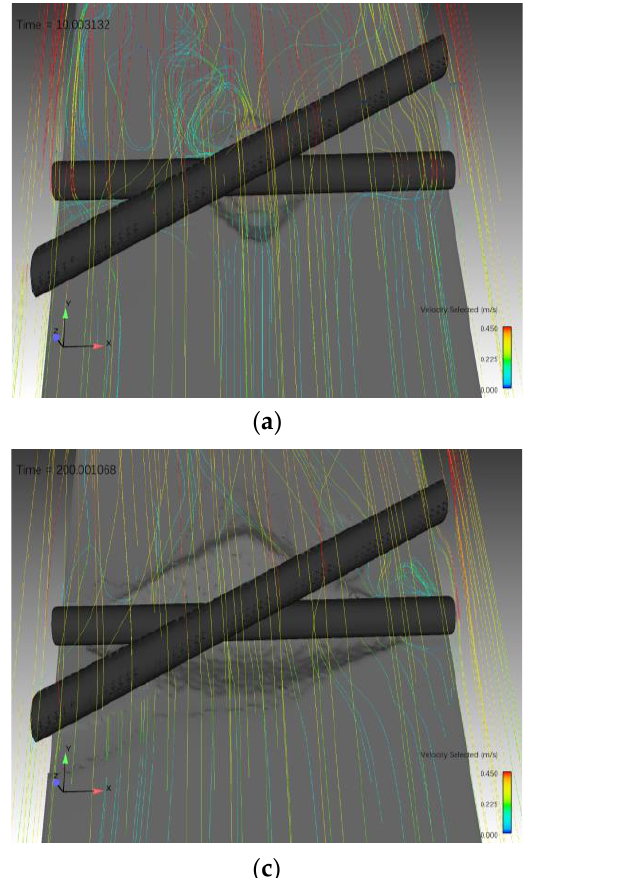
( d ) Figure 11. Streamlines around the pipelines for α = 0°: ( a ) t = 5 s; ( b ) t = 25 s; ( c ) t = 50 s; ( d ) t = 150 s. Figure 12 shows the flow structures around the two intersecting pipelines with an angle of 30° at different stages. It can be observed that the flow structures are more com-